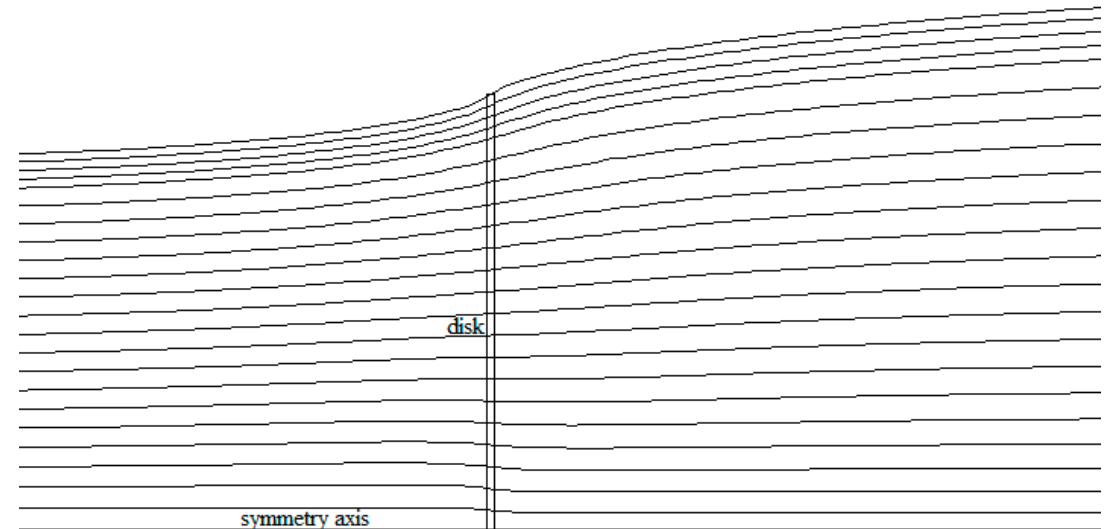
Figure A3. Step 1 solution streamlines defining a set of annular elements.